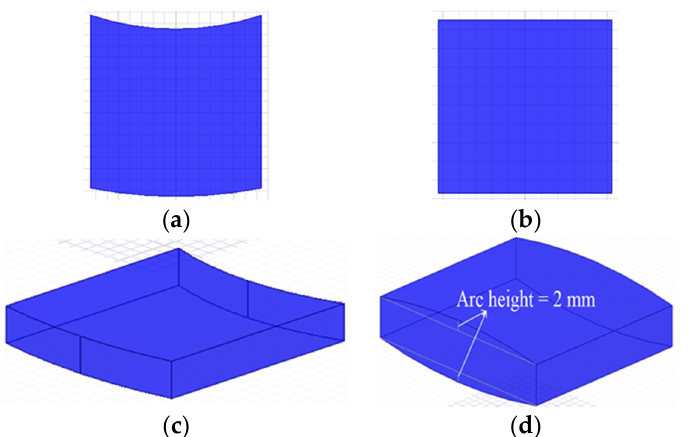
Figure 4. Winding type ( a ) core wound, ( b ) tooth wound.